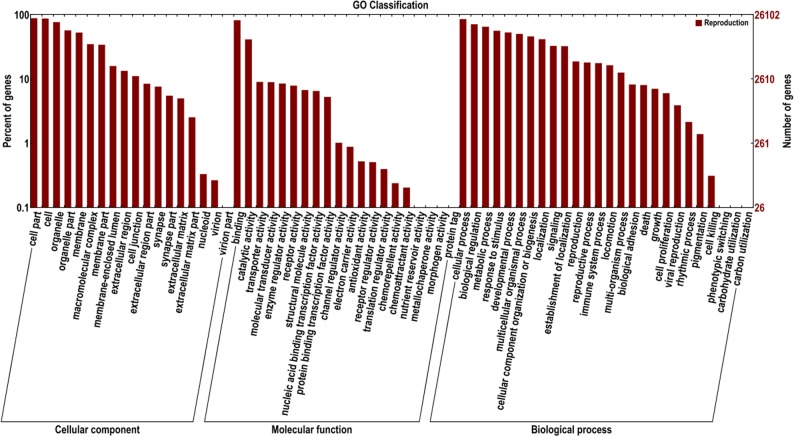
Functional annotation of assembled sequences based on gene ontology (GO) categorization.GO analysis was performed for three main categories: cellular components, molecular function, and biological processes.